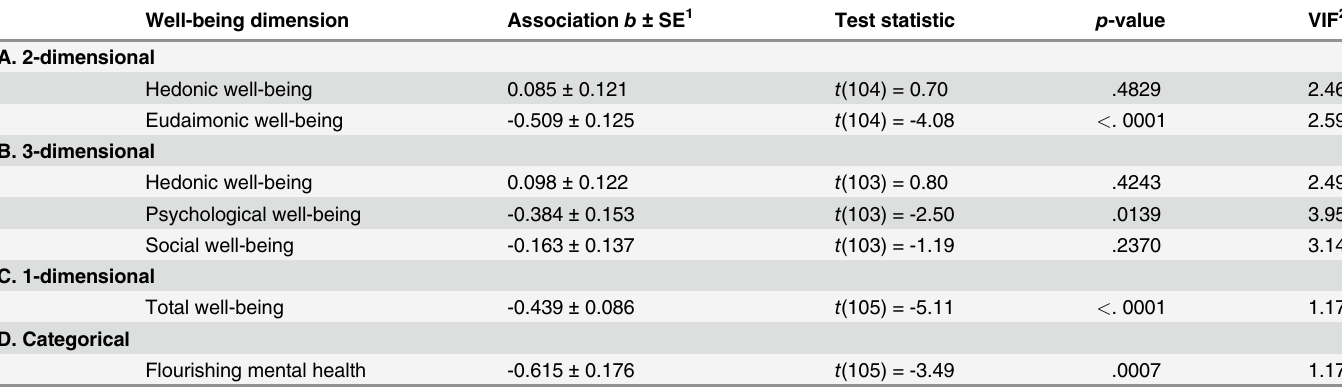
Table 2. Association of well-being with gene expression: Confirmation Study. Well-being